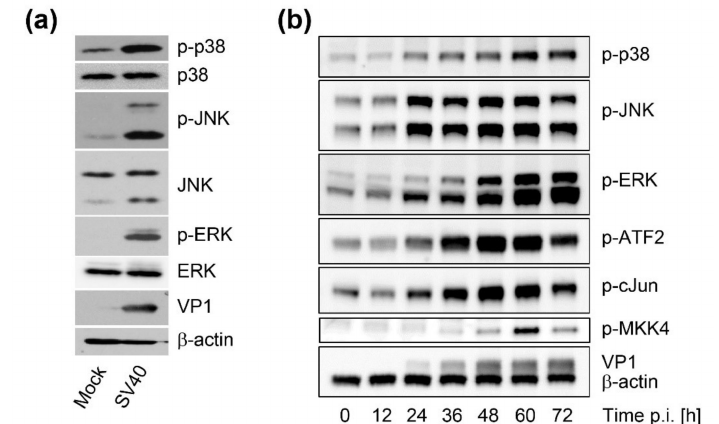
Figure 5. SV40 infection activates intracellular signaling pathways at late times after infection. ( a ) Western blot analysis of phosphorylated and total p38, JNK, and ERK in mock-infected or SV40-infected CV-1 cells 48 h.p.i.: VP1 and beta-actin expression are shown as controls; ( b ) Western blot analysis of CV-1 cells over the time course of SV40 infection: Samples harvested at the indicated h.p.i. were analyzed for phosphorylated p38, JNK, ERK, MKK4, ATF2, and c-Jun as well as for beta-actin and VP1 expression.